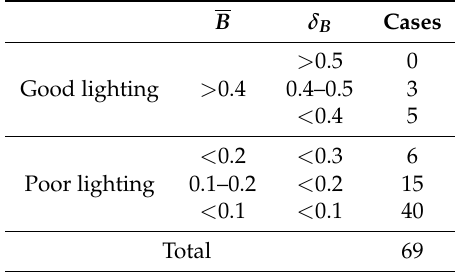
Table 4. Image brightness characteristics in false-negative cases.